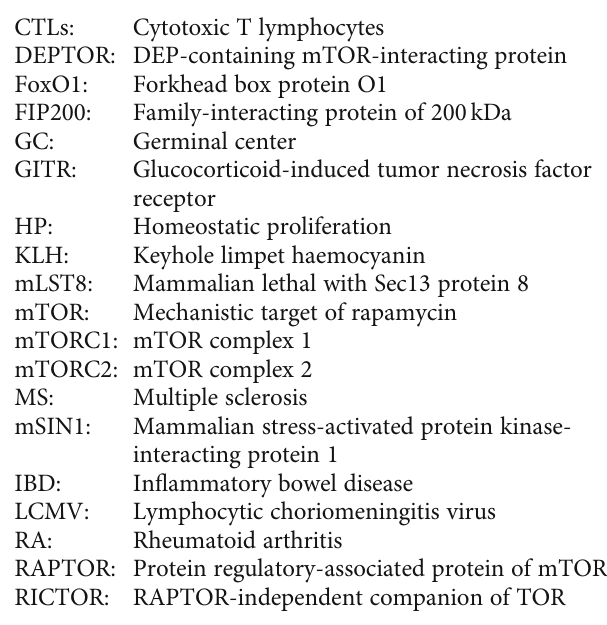
Figure 7: The regulation of mTOR on Th9 cell di ff erentiation. Th9 cell di ff erentiation is positively regulated by mTORC1 and mTORC2. mTORC1 positively regulates Th9 cell di ff erentiation through the HIF1 α -dependent glycolytic pathway and promotes the histone acetylation of IL-9 promoter. mTORC2 positively regulates IL-9 and Th9 cell di ff erentiation mainly via the AKT-FoxO1 signaling pathway. mTORC2 also could regulate the expression of IRF4 through a FoxO1/FoxO3a-independetn pathway, while the detailed mechanism has not been